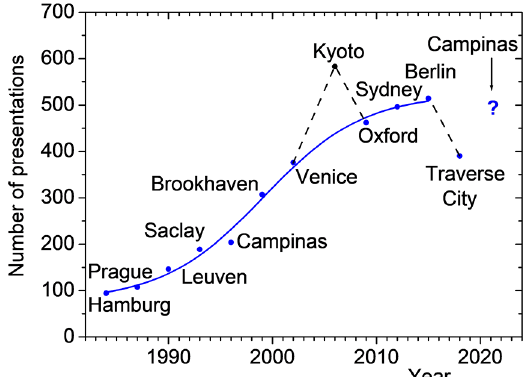
Figure 7. Number of abstracts referring to lectures and communications presented at the International SAS Conferences held at the different indicated